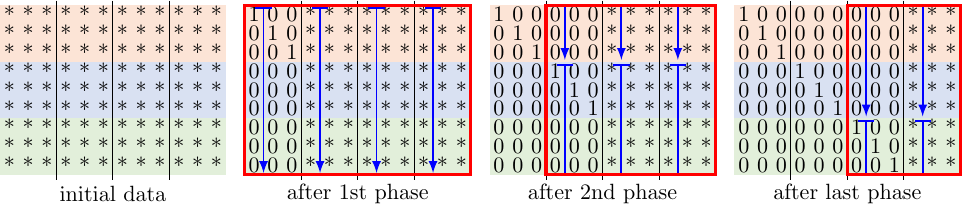
Figure 4: Visualization of the data memory for the single-pass approach for an ( n − k ) × n = 9 × 12 matrix using a column-block size of s = 3. The single-pass approach requires ( n − k ) /s = 9 / 3 = 3 phases of n/s = 12 / 3 = 4 steps in the first phase down to two steps in the last phase. Asterisks denote random data. Corresponding sets of rows are marked in the same color. Red boxes show which matrix parts have been